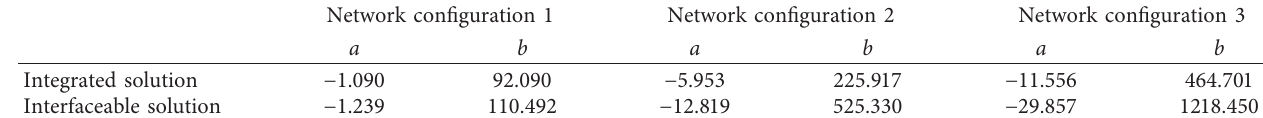
Table 2: Numerical values of calibrated parameters of function f � f ( v ) .